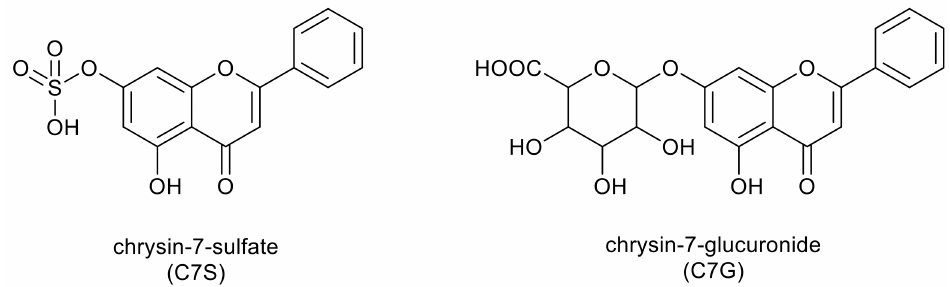
Figure 3. Two dominant products of chrysin metabolism in